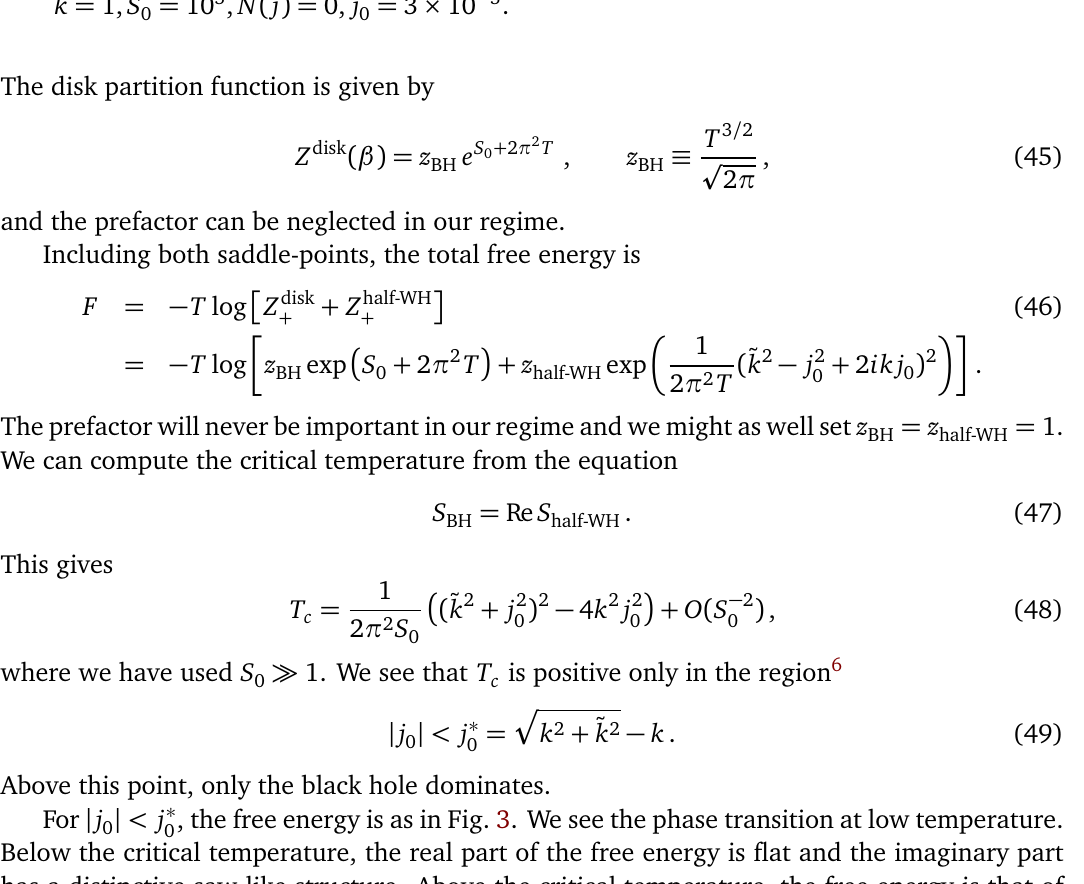
Figure 3: Real and imaginary parts of the free energy as a function of the